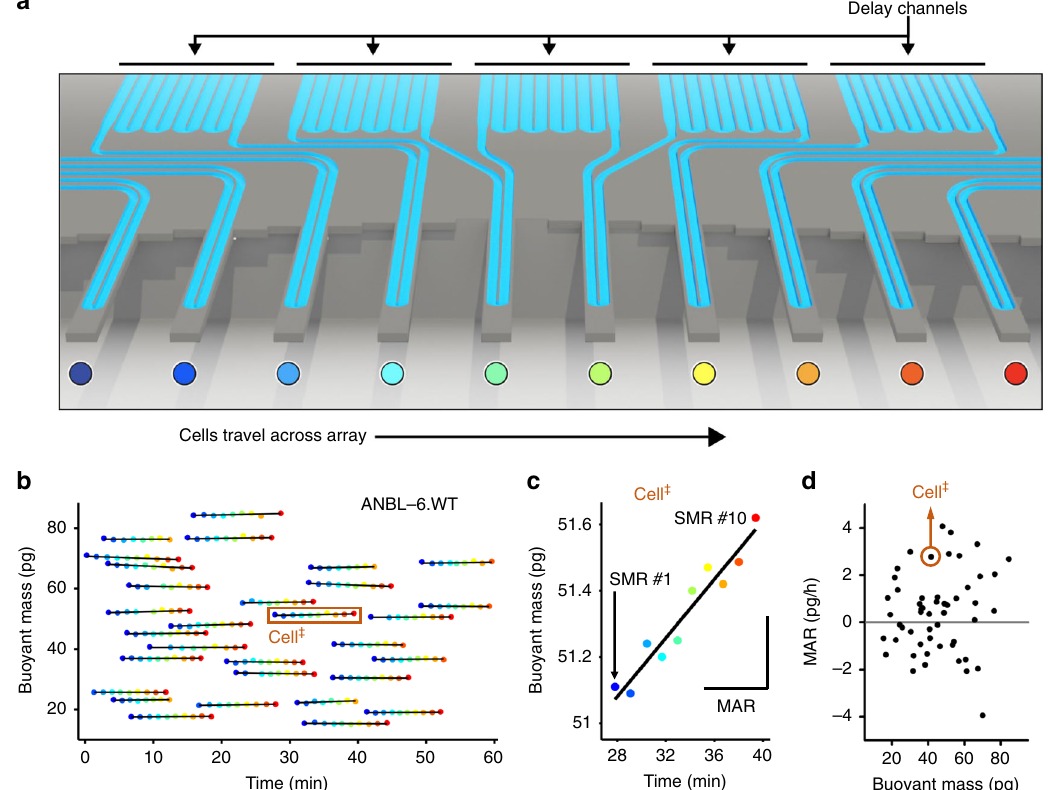
Fig. 1 MAR measurements characterize heterogeneity in cell growth across human MM cell lines. Serial suspended microchannel resonator (sSMR) work fl ow schematics: a Cells pass through the sSMR device. Each cell is weighed multiple times over a 15-min interval in the sSMR device, which consists of multiple sensors that are fl uidically connected in series and separated by delay channels (not all is shown). This design enables a stream of cells to fl ow through the device such that different sensors can concurrently weigh fl owing cells in the stream, revealing single-cell MARs. b Real-time and high-throughput monitoring of mass change for ANBL-6.WT cells with sSMR device. c The change in the cell mass highlighted with a box in Fig. 1b, where blue (SMR #1) to red (SMR #10) dots correspond to the mass of the same cell sequentially measured with 10 different sensors. MAR is calculated from the slope of the linear fi t applied to the mass vs. time data. d MAR calculated from each individual cell trace is plotted with respect to the buoyant mass of each cell. The cell highlighted in Fig. 1b is denoted with a circle. Number of cells in MAR measurement; n =